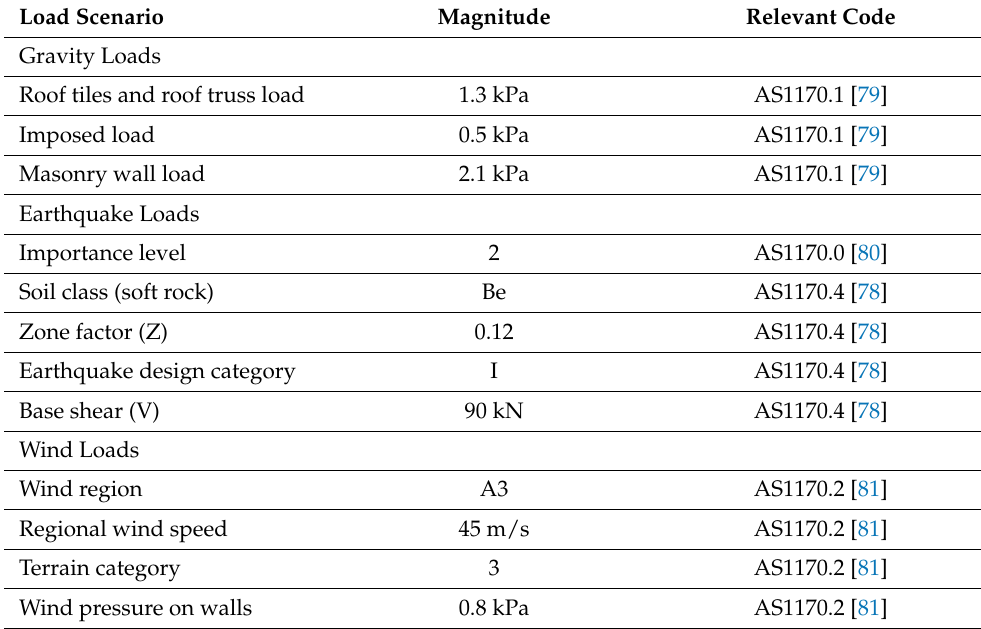
Table 2. Loading scenarios and